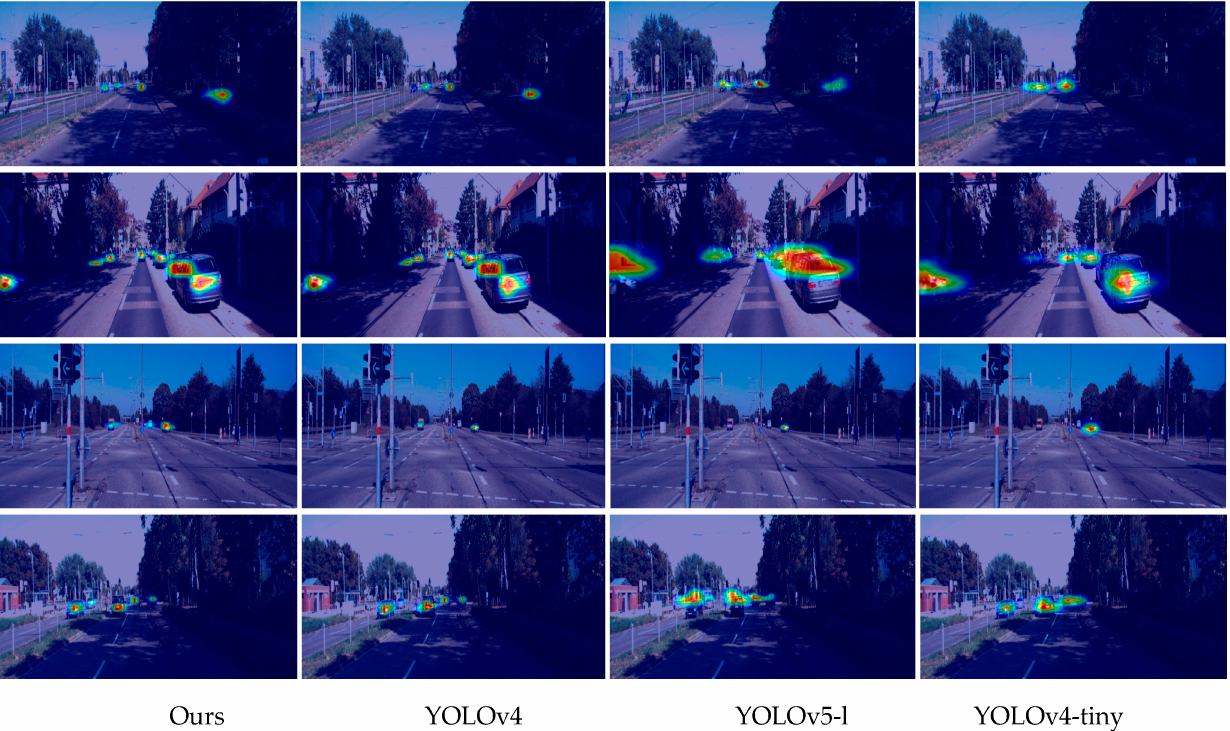
Figure 12. Heat map visualization results of detection results for different models in different scenarios in the KITTI dataset. The first column shows our results, the second column shows the results for YOLOv4, the third column shows the results for YOLOv5-l and the fourth column shows the results for YOLOv4-tiny.